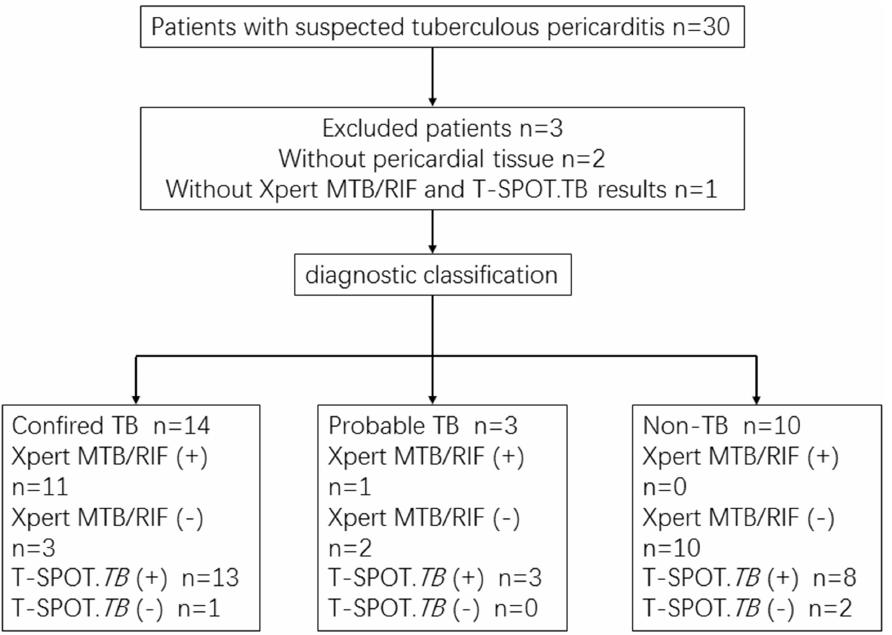
Fig 1. Flowchart showing the classification of patients of included in the study. TB: